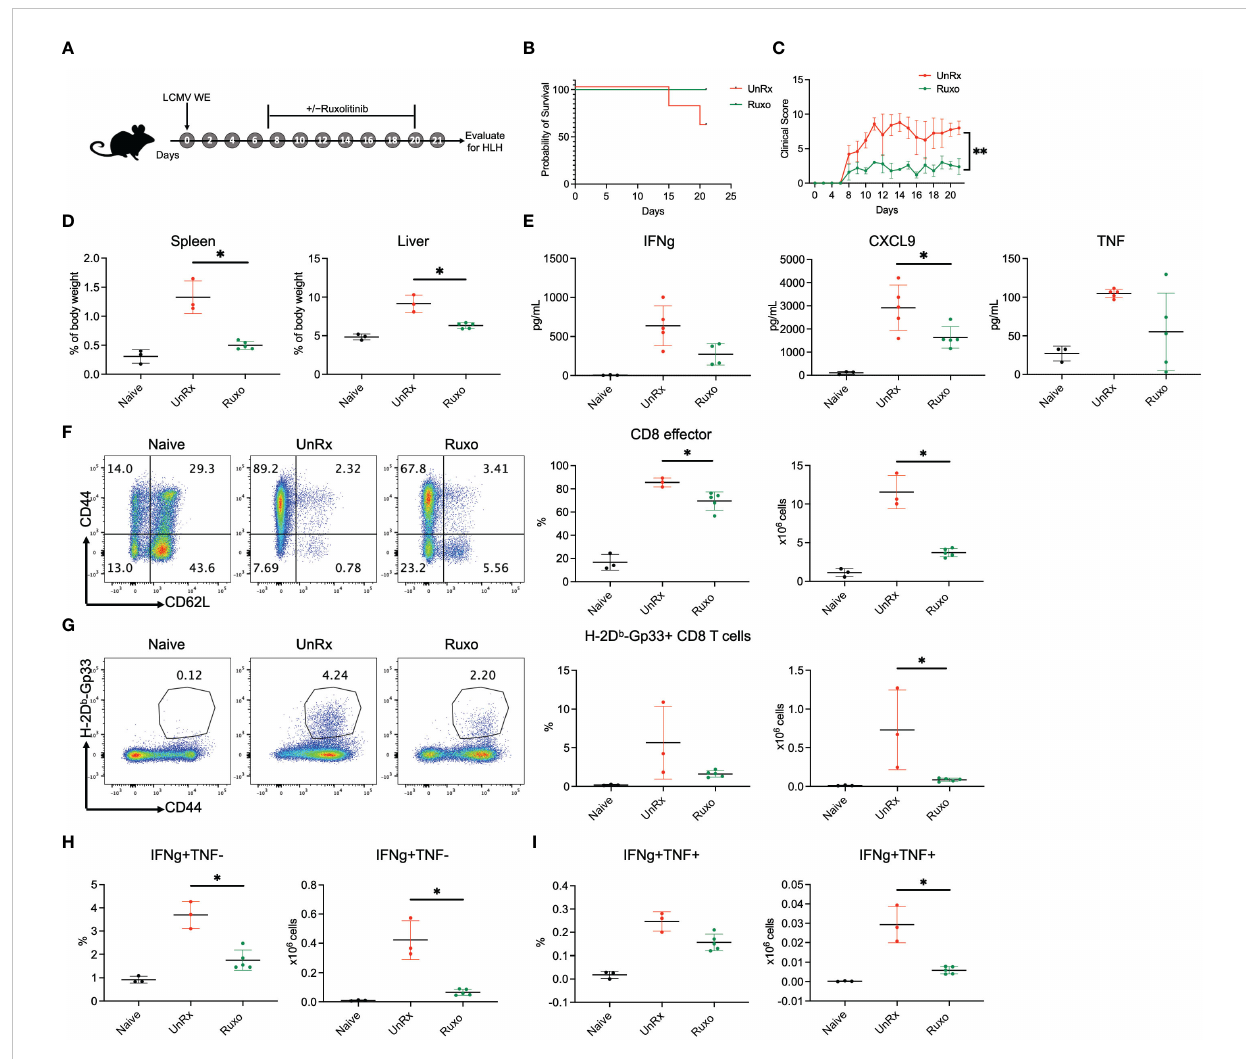
FIGURE 1 Ruxolitinib lessens the manifestations of disease in Prf1 − / − mice infected with LCMV WE. (A) Schematic representation of the experiment; Prf1 − / − mice were infected with LCMV WE and left untreated (UnRx) or treated with ruxolitinib (as described in the Methods) starting on day 7 p.i. and continuing until day 20 p.i. Naïve mice served as a negative control. Mice were euthanized and HLH parameters assessed on day 21 p.i. Survival curves (B) and clinical scores (C) of mice that were infected with LCMV WE and not treated (UnRX; 2 out of 5 mice died on day 15 and day 20 p.i.) or treated with ruxolitinib (5 of 5 mice survived). The clinical scores of mice that did not survive were excluded after the day of their euthanasia. (D) Spleen and liver weights depicted as a proportion of the fi nal body weight. (E) Levels of serum IFNg, CXCL9 and TNF (F) Representative fl ow plots (left) and summary graphs (right) showing frequency and absolute numbers of splenic CD44+CD62L − effector CD8 T cells gated on total CD8 T cells. (G) Representative fl ow plots (left) and summary graphs (right) showing frequency and absolute numbers of splenic CD44+Gp33 tetramer +CD8 T cells. (H) Frequency (left) and absolute numbers (right) of IFNg+TNF − CD8 T cells gated on CD44+CD62L − effector CD8 T cells. (I) Frequency (left) and absolute numbers (right) of IFNg+TNF+ CD8 T cells gated on CD44+CD62L − effector CD8 T cells. Each data point represents one mouse. * P <